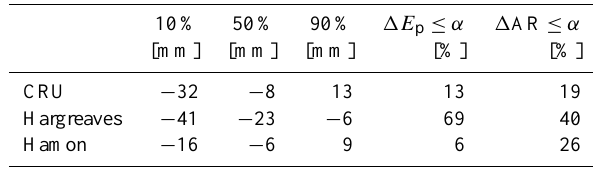
Table 1. Statistics of the average change of the three E p estimates. The first three columns depict quantiles of 1E p ; the forth and fifth columns denote the relative frequency of basins with significant change ( α = 0 . 05, two sample t-test) for E p and the aridity index (AR). 10% 50% 90% 1E p ≤